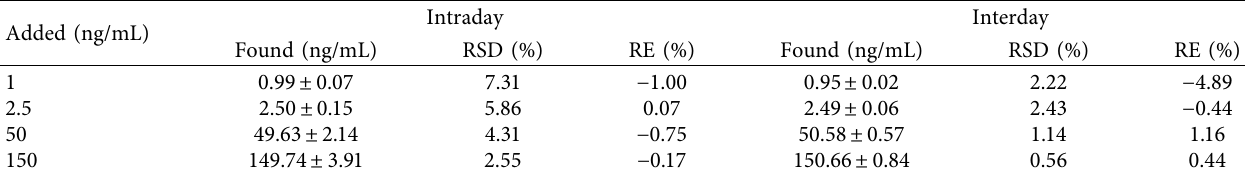
Figure 2: Typical chromatograms from blank plasma (a), blank plasma (b) added with standard solution, and an authentic plasma specimen (c) after the oral administration of tropifexor by beagle dogs. Table 2: The accuracy and precision of tropifexor in Beagle plasma ( n �